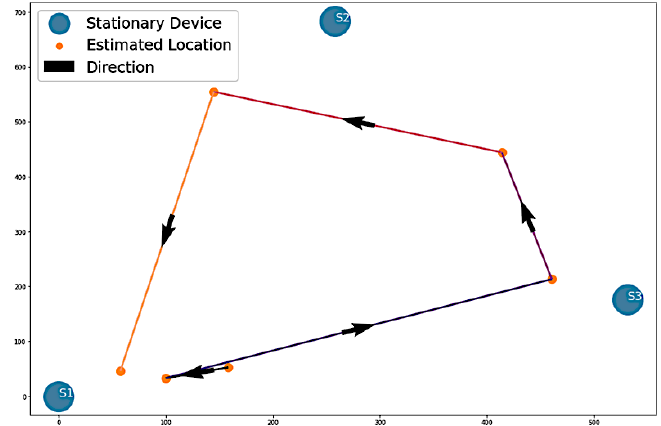
Figure 15. Algorithm 1 ’ s estimation of Path 3.